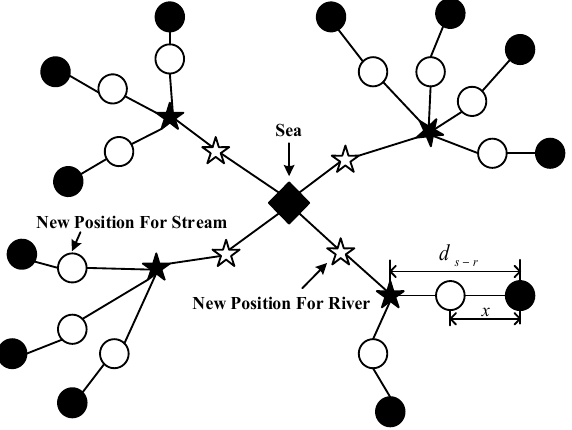
Figure 3. Brief schematic view of WCA [50].